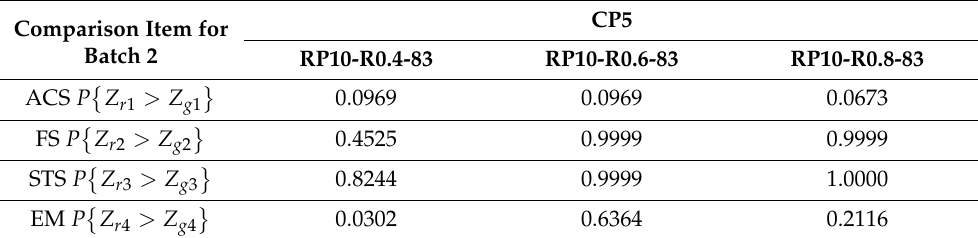
Table 8. Probability that the CVMC for steel fiber concrete is greater than that of concrete used for batch